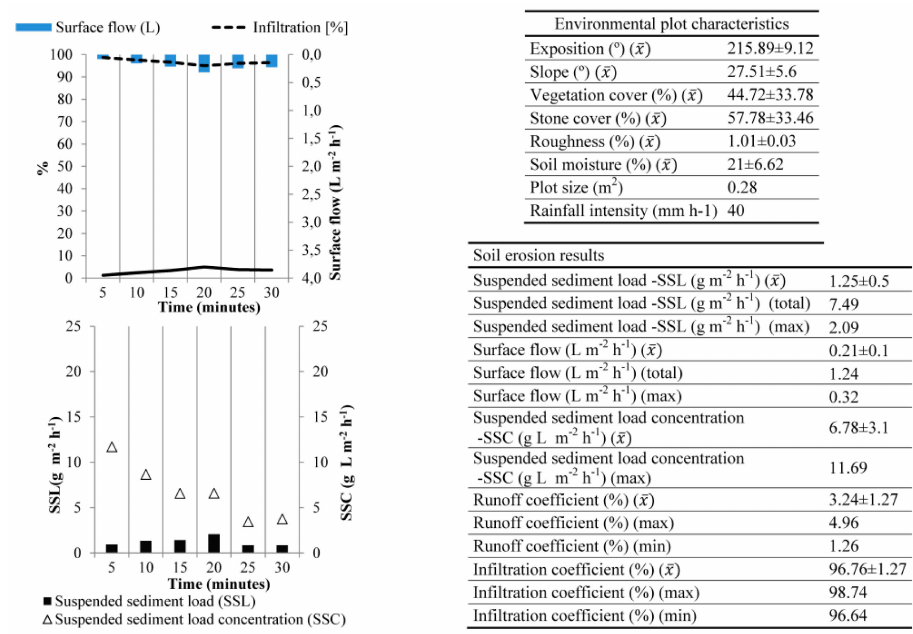
Figure 2. Rainfall simulations in Ruwer-Mosel valley (Trier,